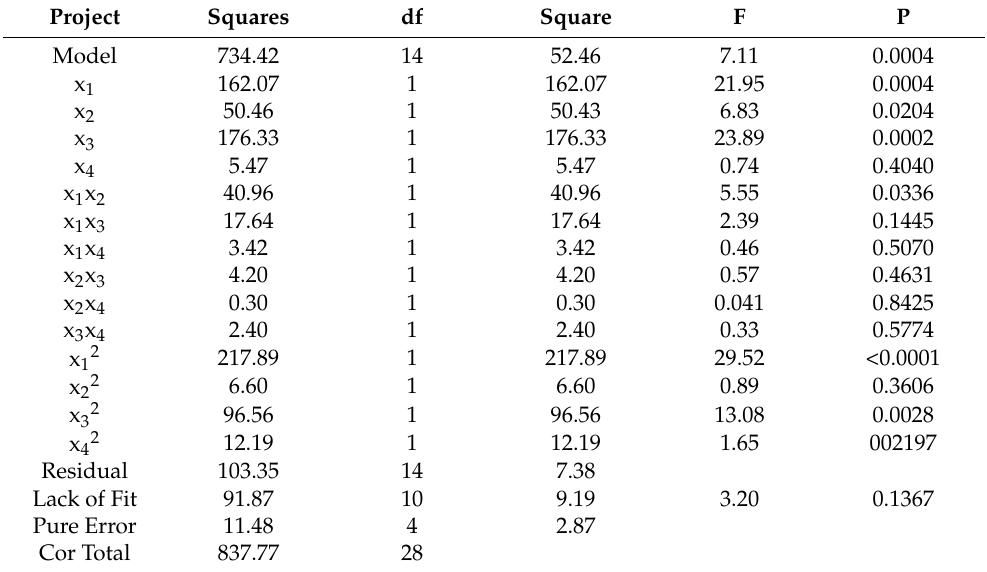
Table 4. Analysis of variance for regression model of covering soil